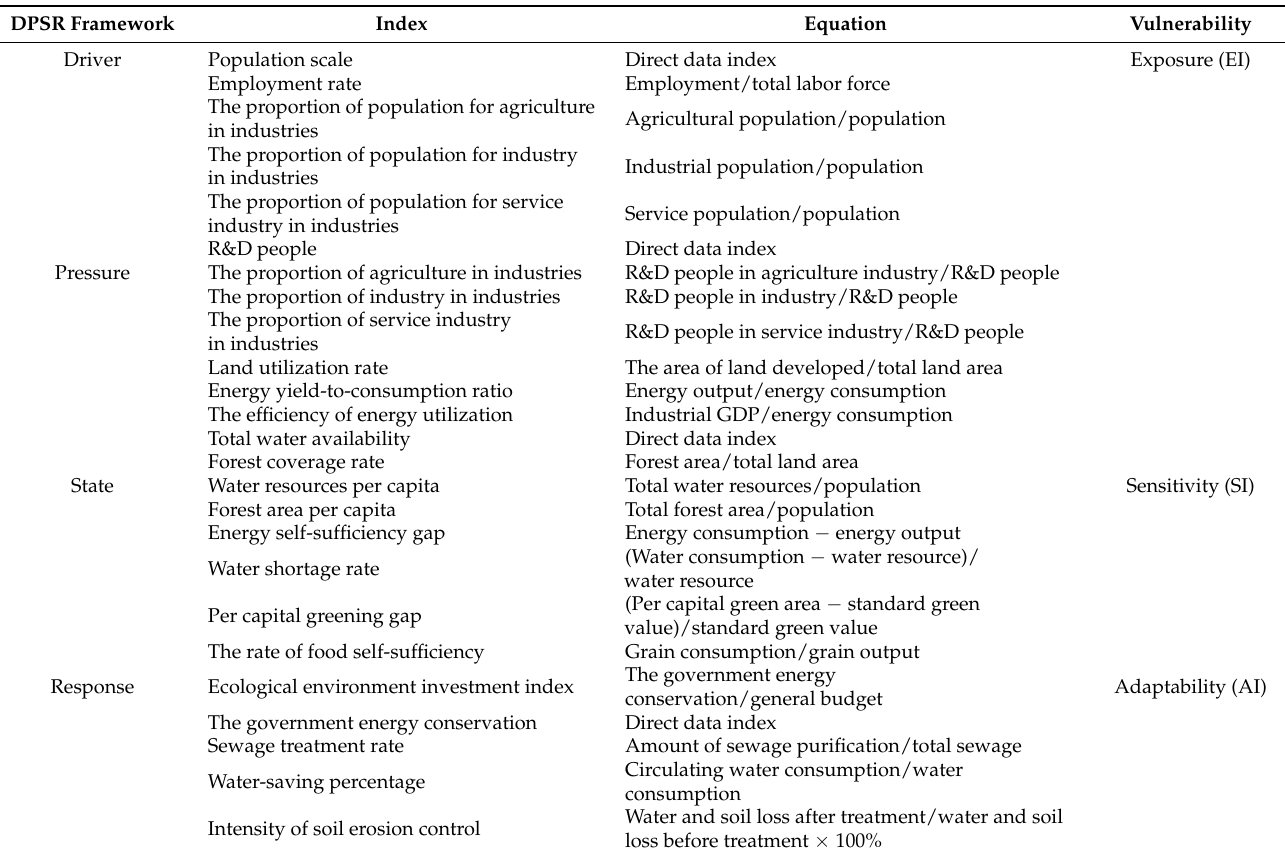
Table 1. Population-driven WFE vulnerability assessment